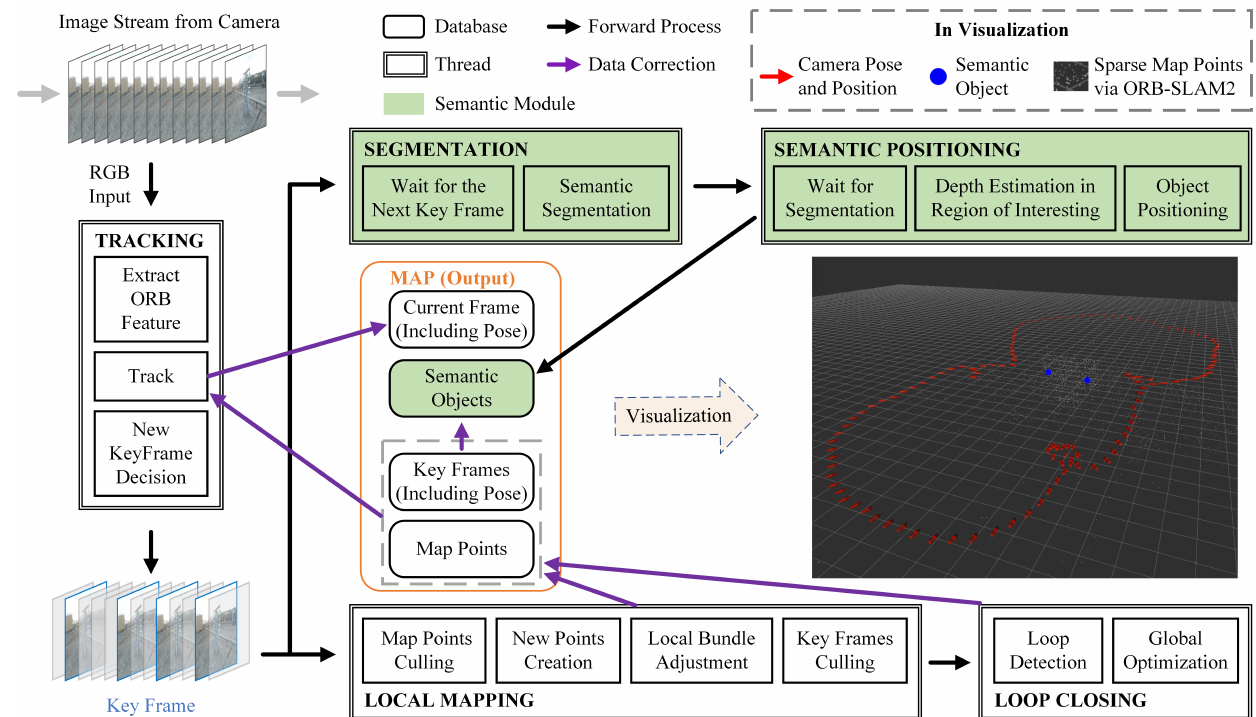
Figure 3. The framework of